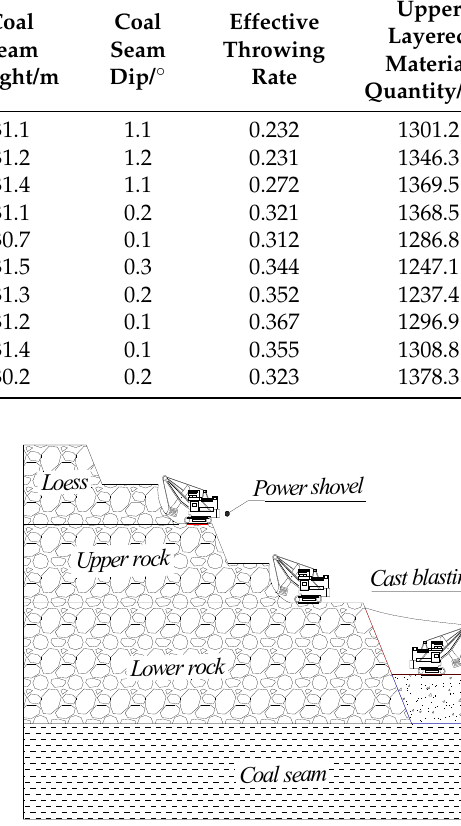
Figure 6. Elevation of Heidaigou open-pit mine comprehensive mining system.